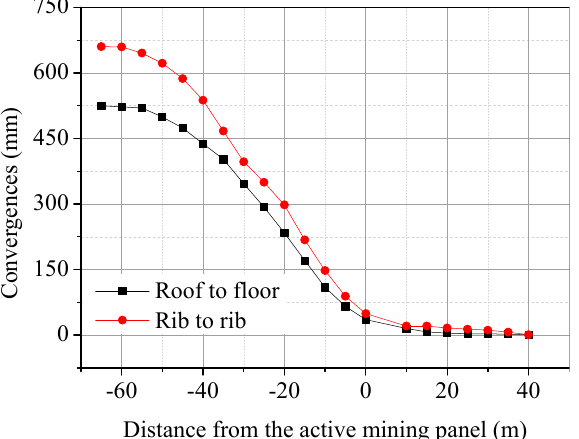
Figure 21. Deformation characteristics of the 6208 tail entry.